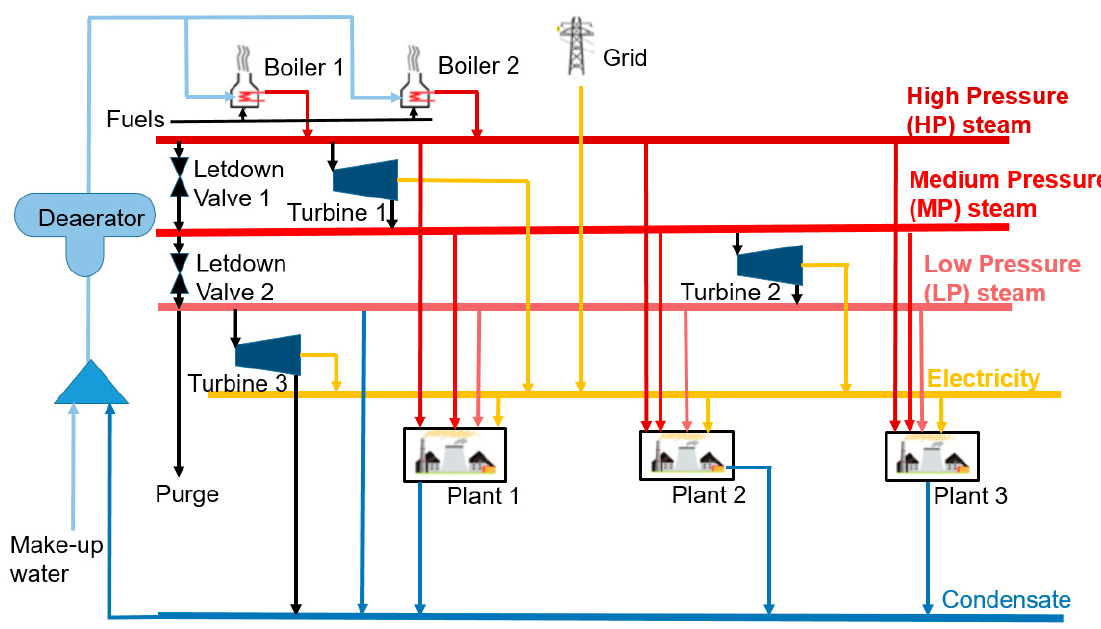
Figure 10. Illustration of industrial Total Site processes with central utility system (adapted from Klemeš et al. [60]).